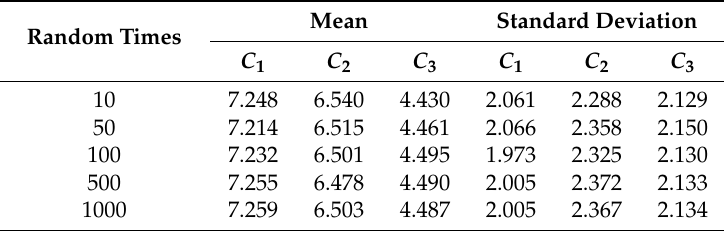
Table 4. Statistical characteristics of decision-making schemes under each random time.